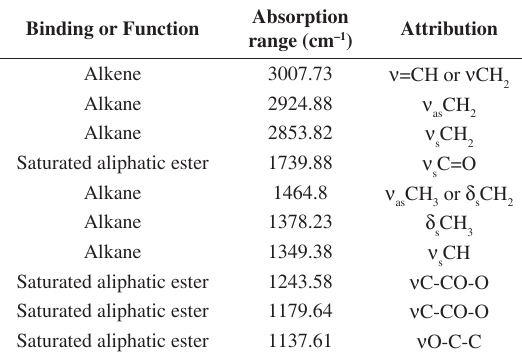
Table 3. Absorption bands indentified in FTIR spectrum for the natural plasticizer. Binding or Function